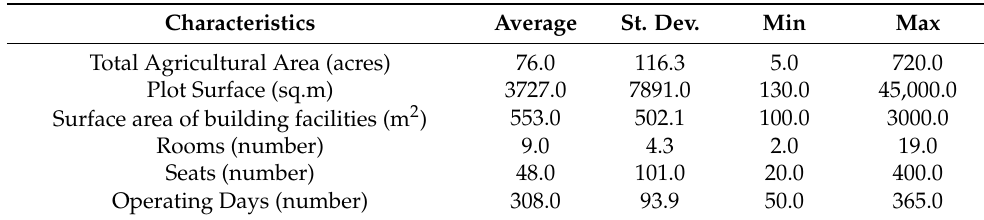
Table 4. Characteristics of Agricultural and Tourism Activities.